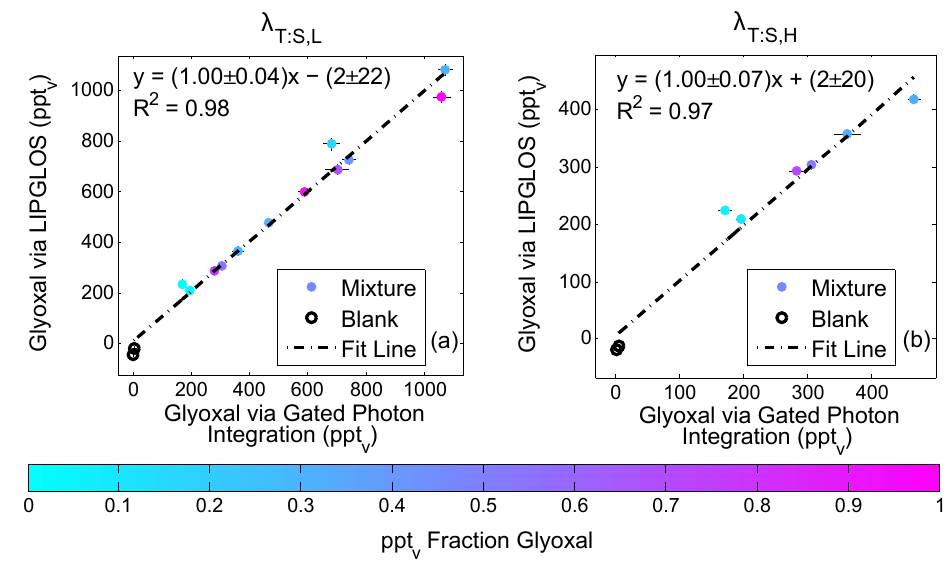
Fig. 6. Results from a simultaneous glyoxal calibration of the LIPGLOS and gated photon integration methods while varying methylglyoxal between 130–5400pptv at λ T : S , L and 130–2500pptv at λ T : S , L aside from the blanks. The color bar represents the fraction of total glyoxal and methylglyoxal pptv that is glyoxal. Displayed errors on y axis values are prefactor fit error. Error bars smaller than the plot markers are to be assumed smaller than the marker ( ± < 19pptv). (a) Mixing ratios determined by LIPGLOS method at λ T : S , L versus those determined by the gated photon integration method. (b) Analogous graph for λ T : S , H .